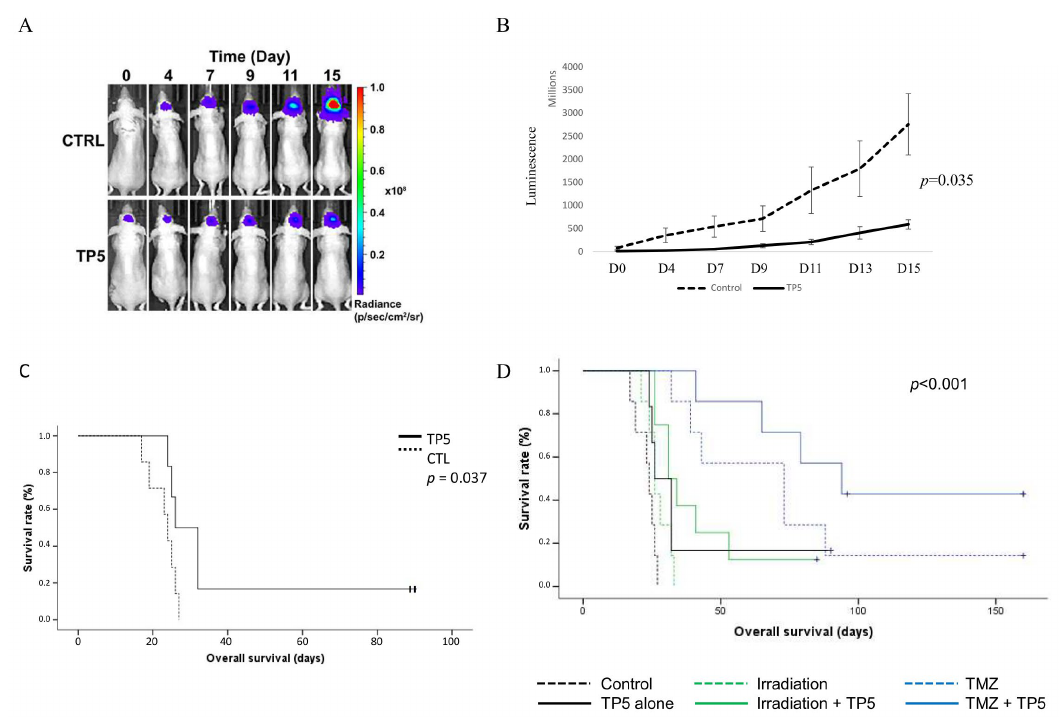
Figure 6. TP5 increases mouse survival alone or in combination with irradiation or temozolomide. ( A ) Representative bioluminescent imaging of control and TP5 only groups on day 0, 4, 7, 9, 11, 15. ( B ) Tumor volume of control and TP5 only groups over time (luminescent signal) is shown from the first day of treatment to the day 15 (first death in the control group). ( C ) Survival curve of control and TP5 only group. ( D ) Mouse overall survival according to the treatment groups is shown: control ( N = 7), TP5 alone (100 mg / kg day 1 and then 50 mg / kg every 2 days, N = 6), Irradiation 6 Gy ( N = 7), TMZ (temozolomide 5 mg / kg for 5 days, N = 7), Irradiation and TP5 ( N = 8), TMZ and TP5 ( N = 7).